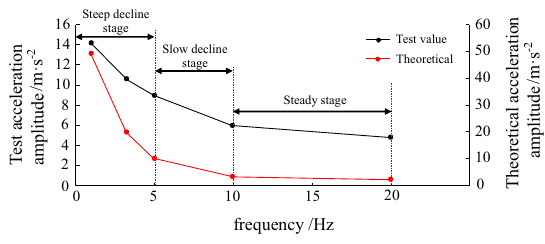
Fig. 3 Curves of maximum acceleration with disturbance frequency